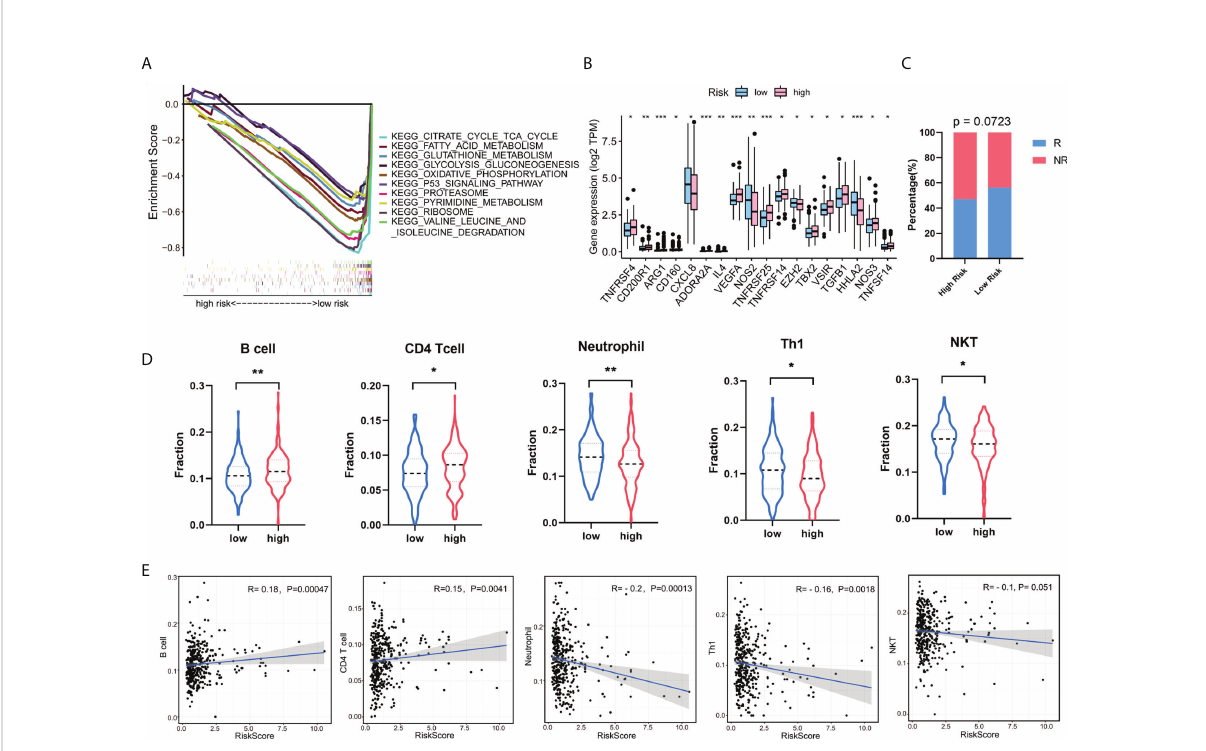
FIGURE 7 Gene set enrichment analysis (GSEA) and the correlation between risk model and tumor-in fi ltrating immune cells. (A) Enrichment analysis of signaling pathways in the risk model. (B) The expression levels of immune-related genes between the high- and low-risk groups. (C) The response of immune checkpoint blockade (ICB) therapy between the high- and low-risk group. R, response; NR, no response. (D) The fraction of tumor immune in fi ltrating cells in the high- and low-risk group. (E) Correlation of risk score with fi ve tumor-in fi ltrating immune cell subtypes. *p < 0.05, **p < 0.01, ***p < 0.001. Th1, T helper 1; NKT, natural killer